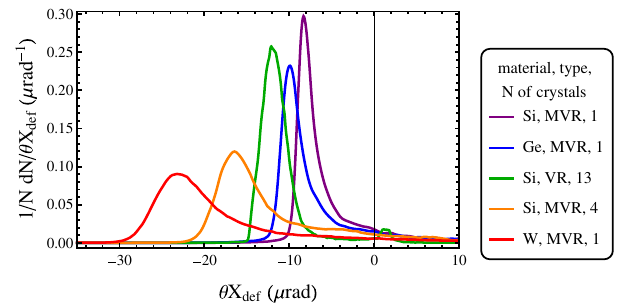
FIG. 8. Comparison of angular distribution behind the crystal for volume reflection and MVROC of 50 TeV protons in one and a sequence of bent silicon crystals and MVROC in bent germanium and tungsten crystals. The length is 10 cm of the silicon crystal or crystal sequence, 5.4 cm of the germanium crystal and 1.9 cm of the tungsten crystal.